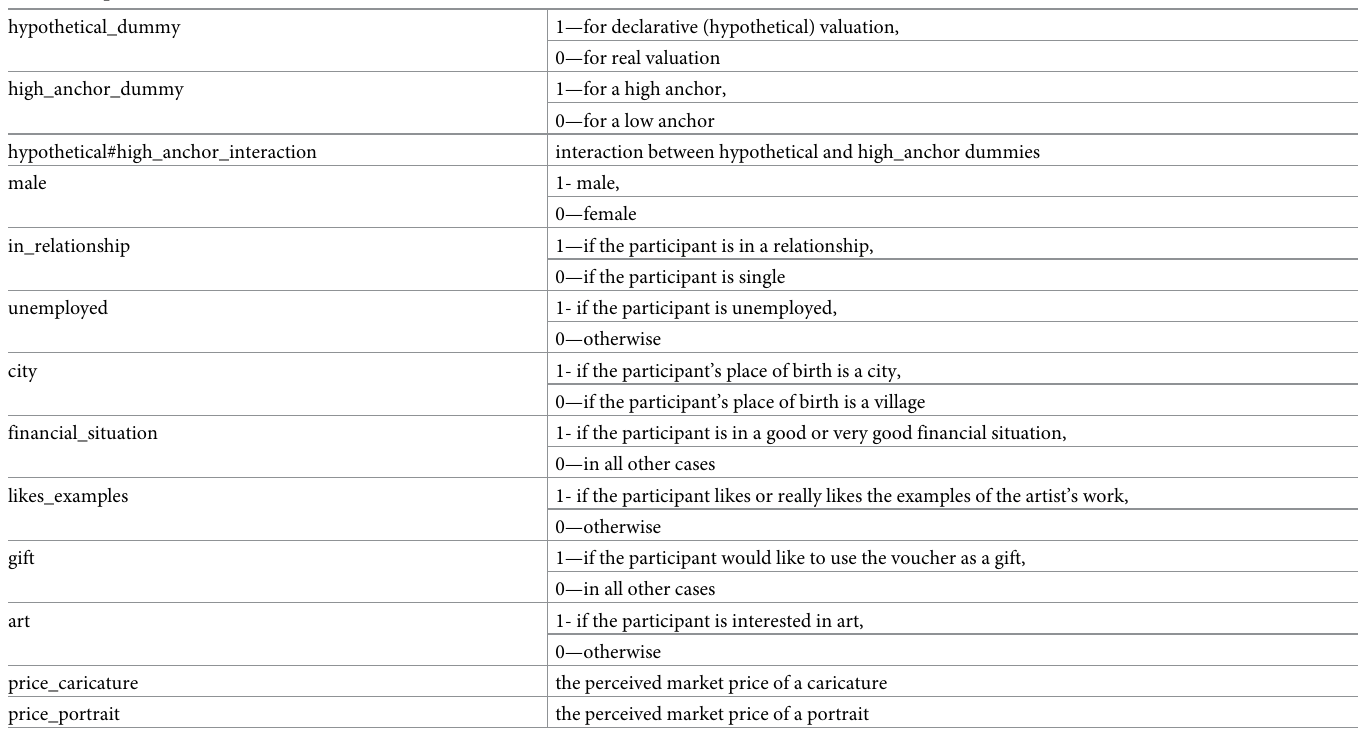
Table 3. Experiment 1: Variable